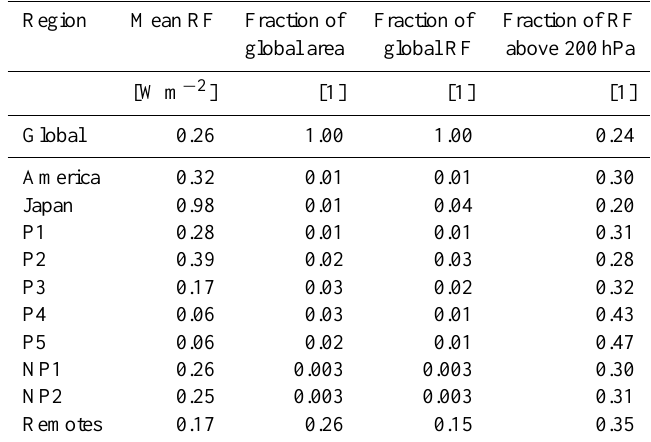
Table 2. Modelled mean forcing and fractions for the regions used in the present analysis (see Fig. 1). Mean RF is the forcing within that region. Fraction of global RF is defined as the fraction of energy deposited, on annual mean, within that region. “Remotes” represents the total of all grey marked regions in Fig. 1. Region Mean RF Fraction of Fraction of Fraction of RF global area global RF above